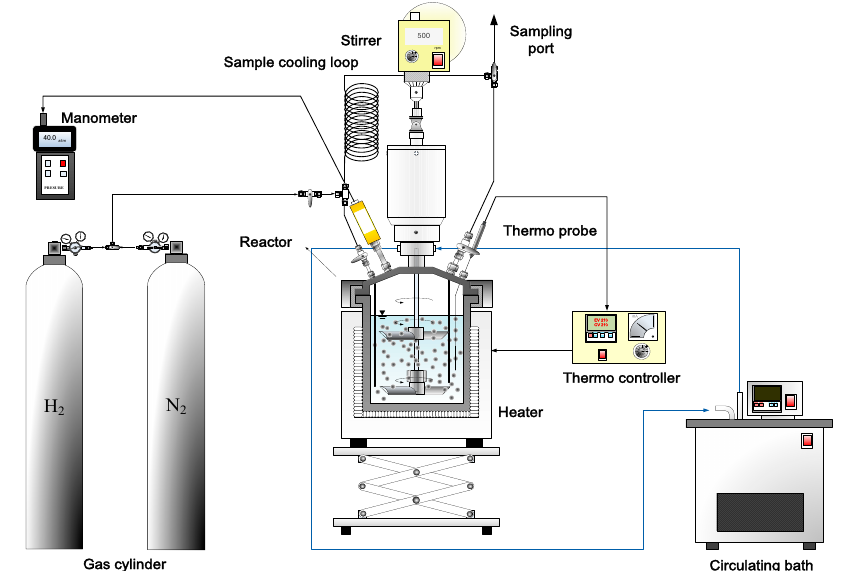
Figure 2. Schematic diagram of the HTC reaction system.